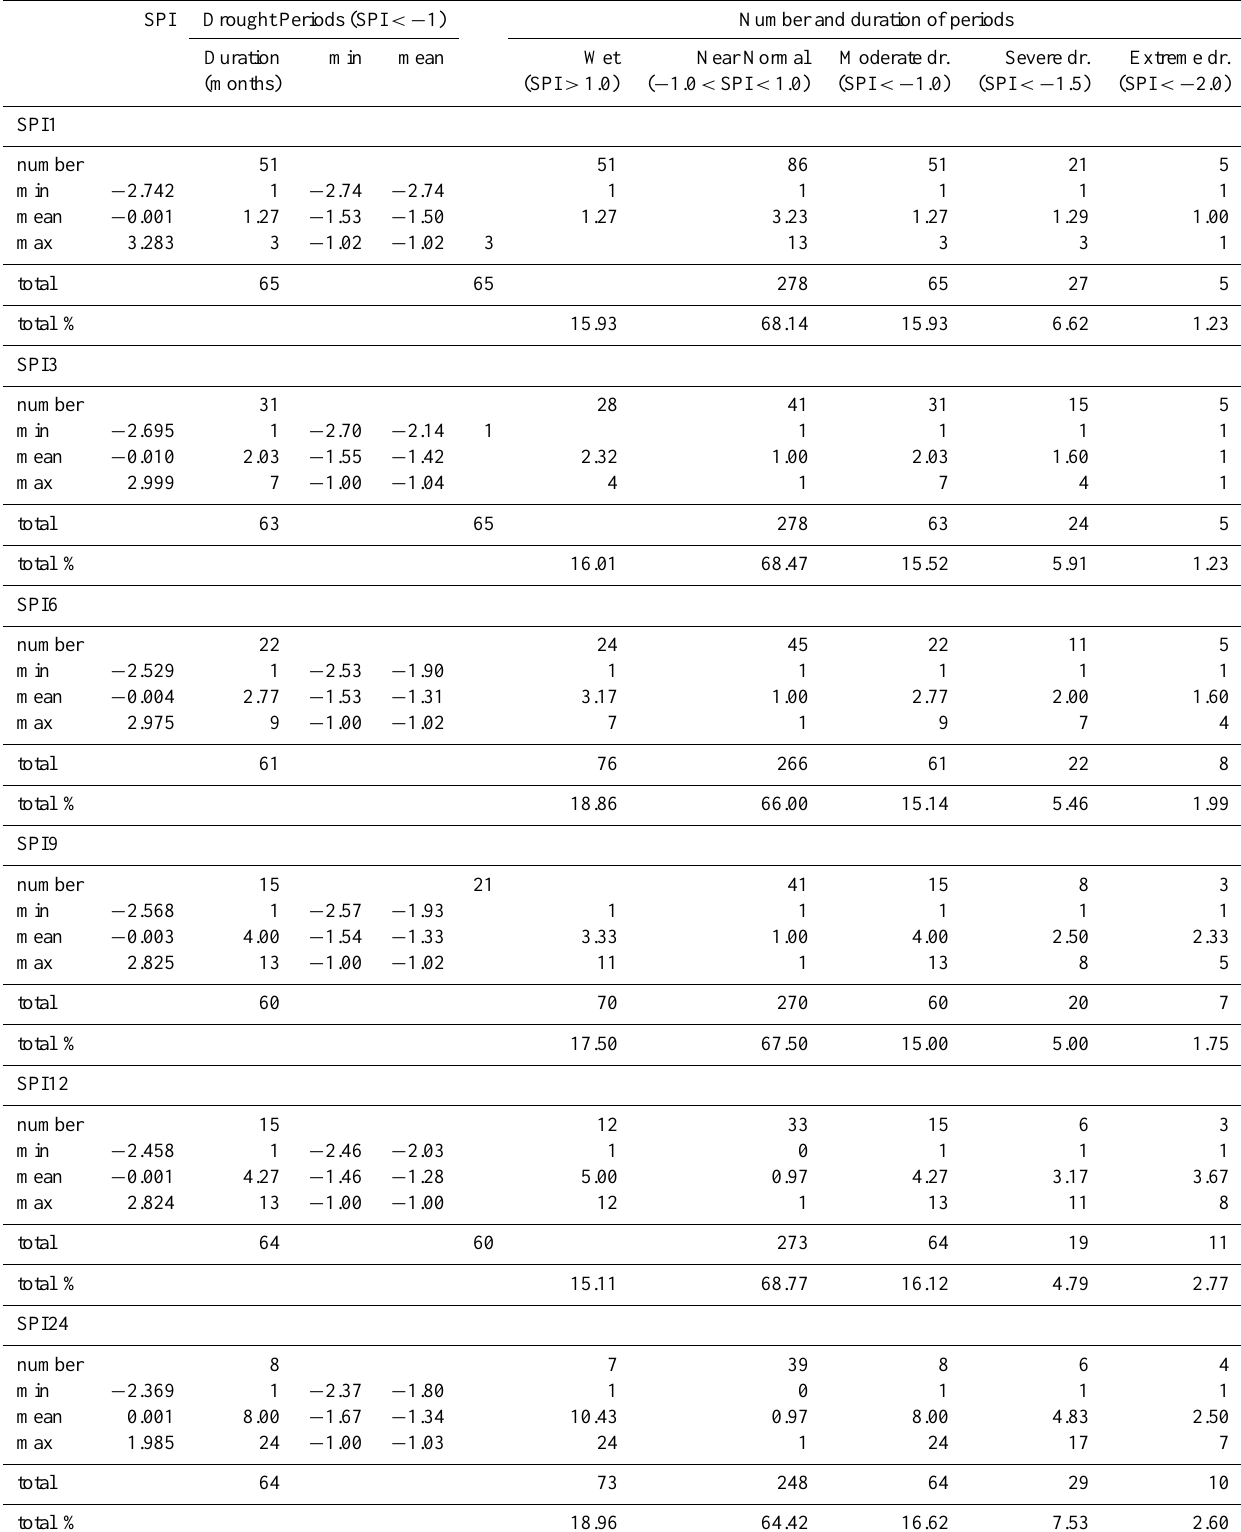
Table 7. Areal precipitation – drought analysis results for all time